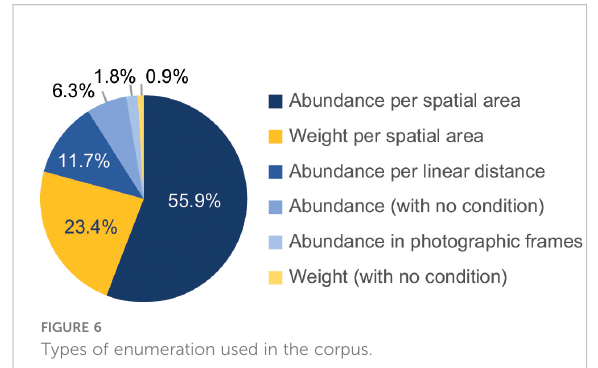
FIGURE 6 Types of enumeration used in the corpus.